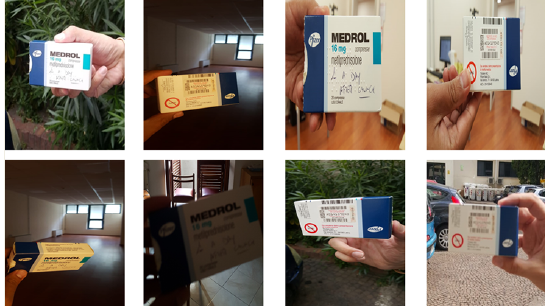
Figure 4. Some manually captured images of the drug